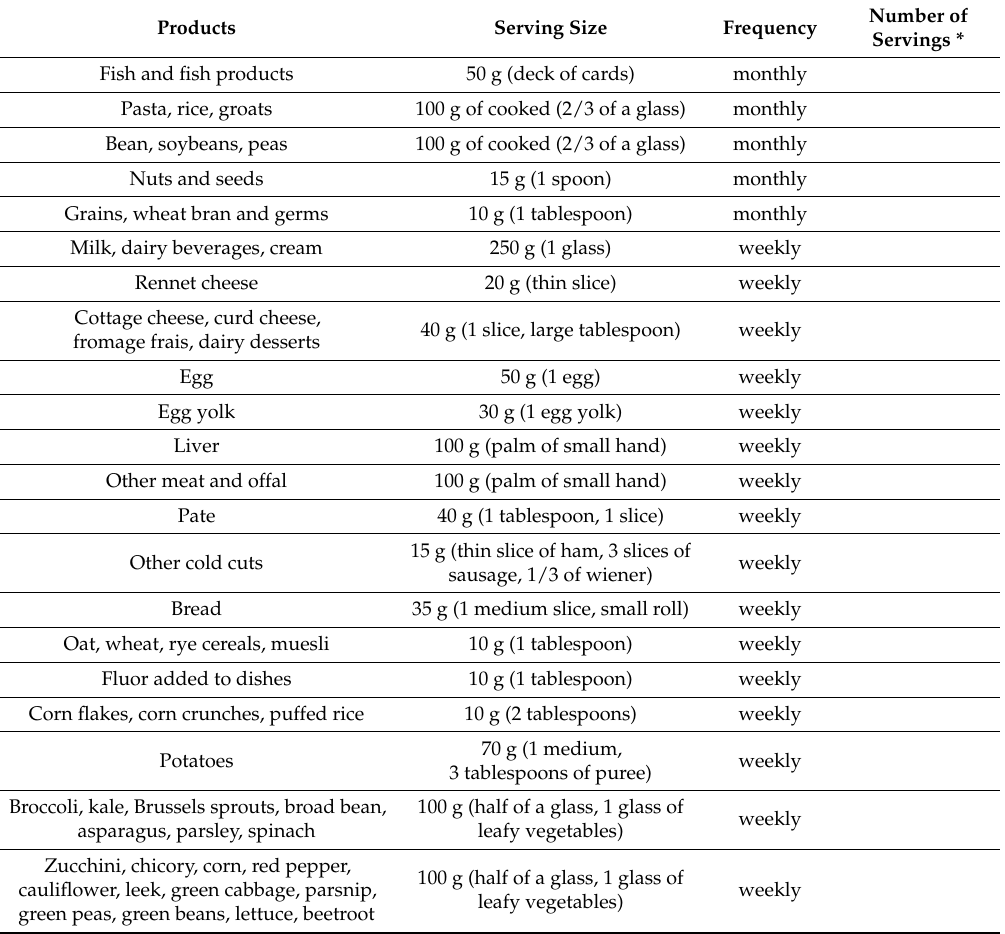
Table 1. The scheme of an applied food frequency questionnaire including food products, serving